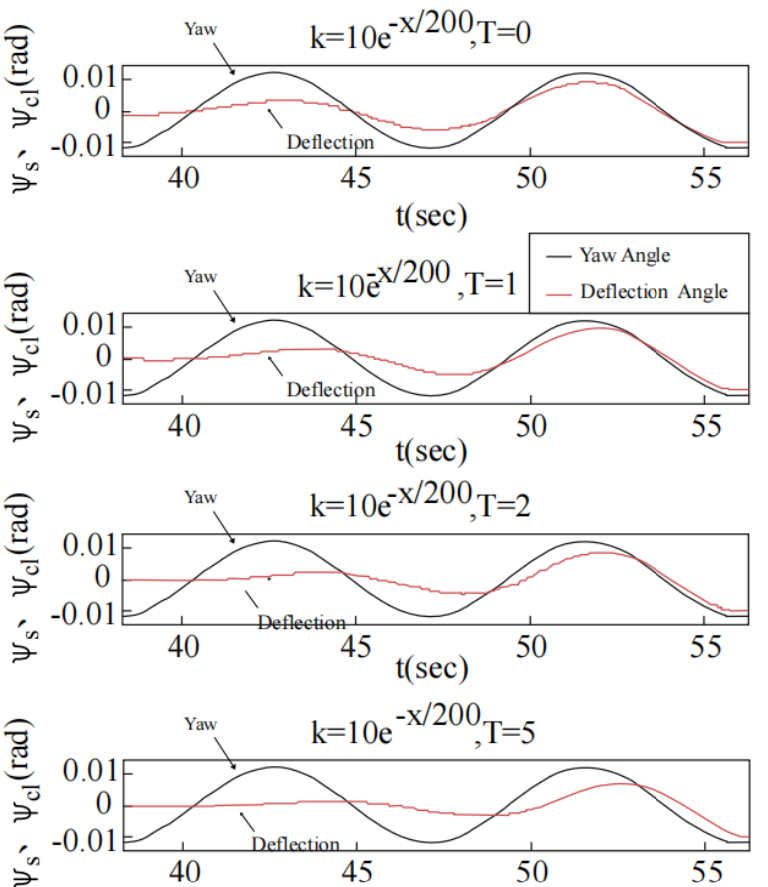
Figure 28. The tracking response curves of measurement axis under inertial tracking strategies with different T